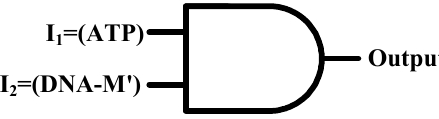
Figure 3. Schematic of an AND logic gate. Table 2. A Boolean operation list.